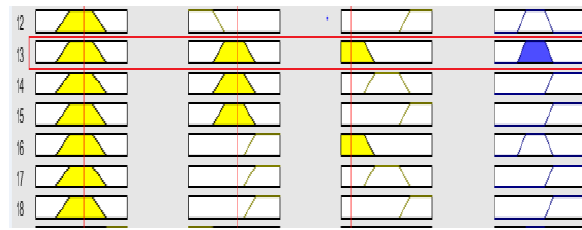
Figure 5a: Final Layer, Lookup diagram of Bad Governance for proposed OGF-SCT-HMT-1-F Expert System.